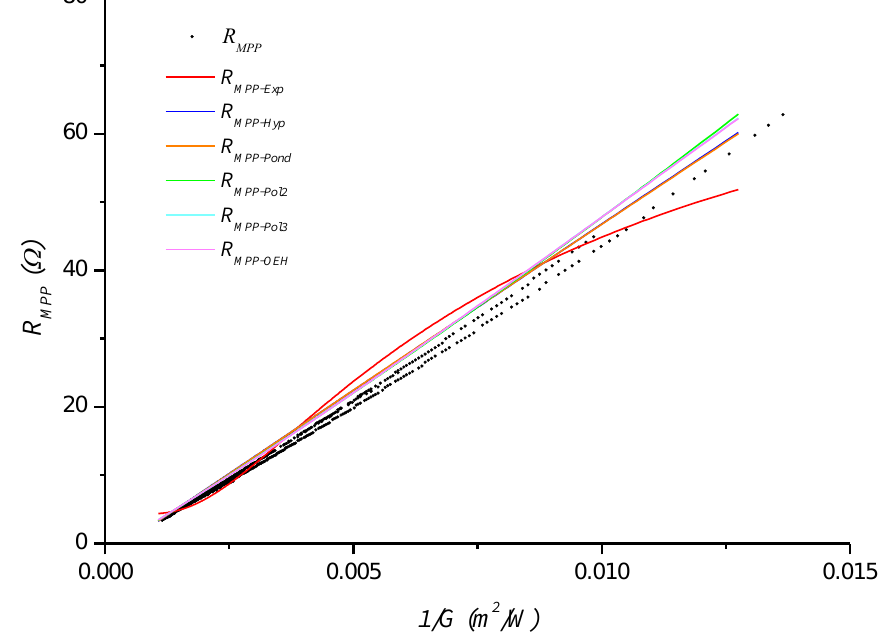
Figure 7. Functions fitted with the D1 data.